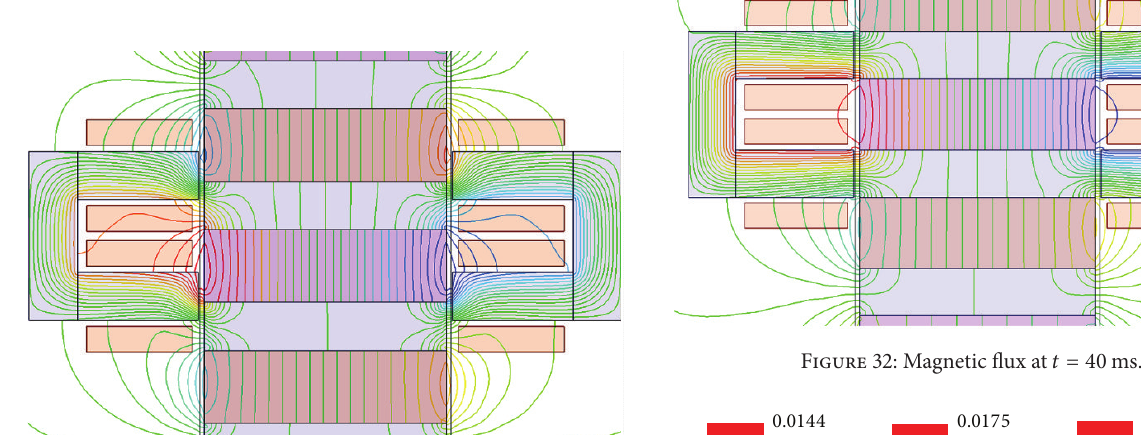
Figure 30: Magnetic flux at 𝑡 = 20 ms.